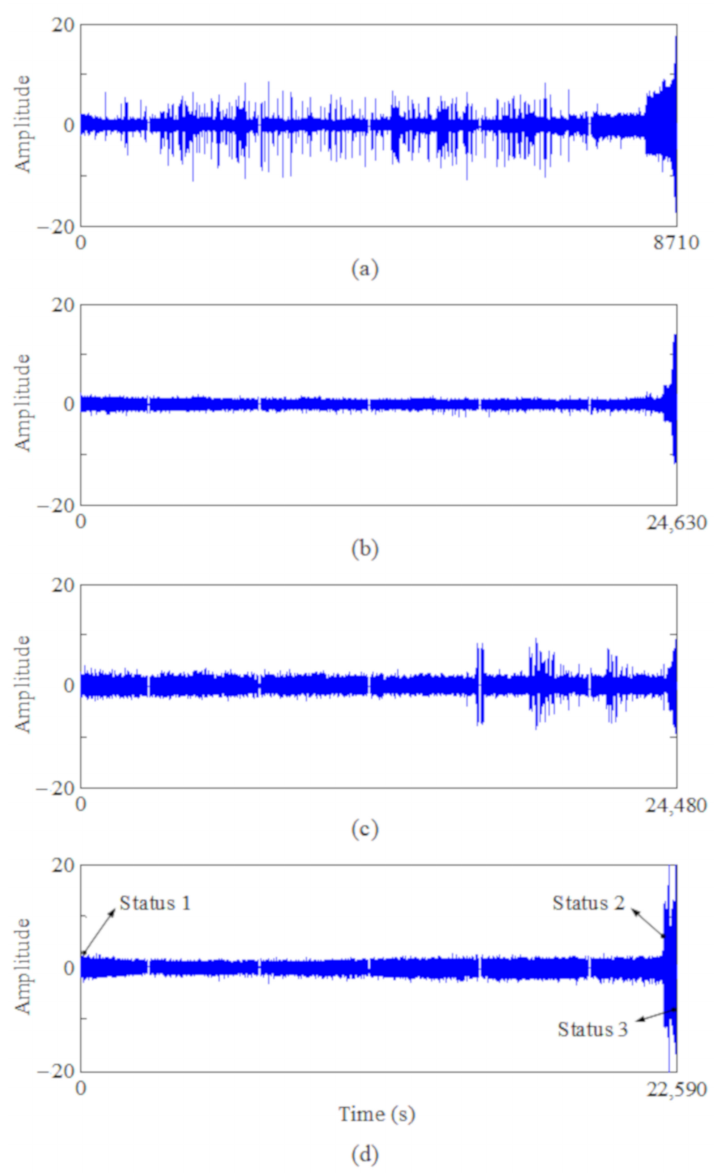
Figure 3. Vibration signals of four bearings: ( a ) bearing 1, ( b ) bearing 2, ( c ) bearing 3, and ( d ) bearing